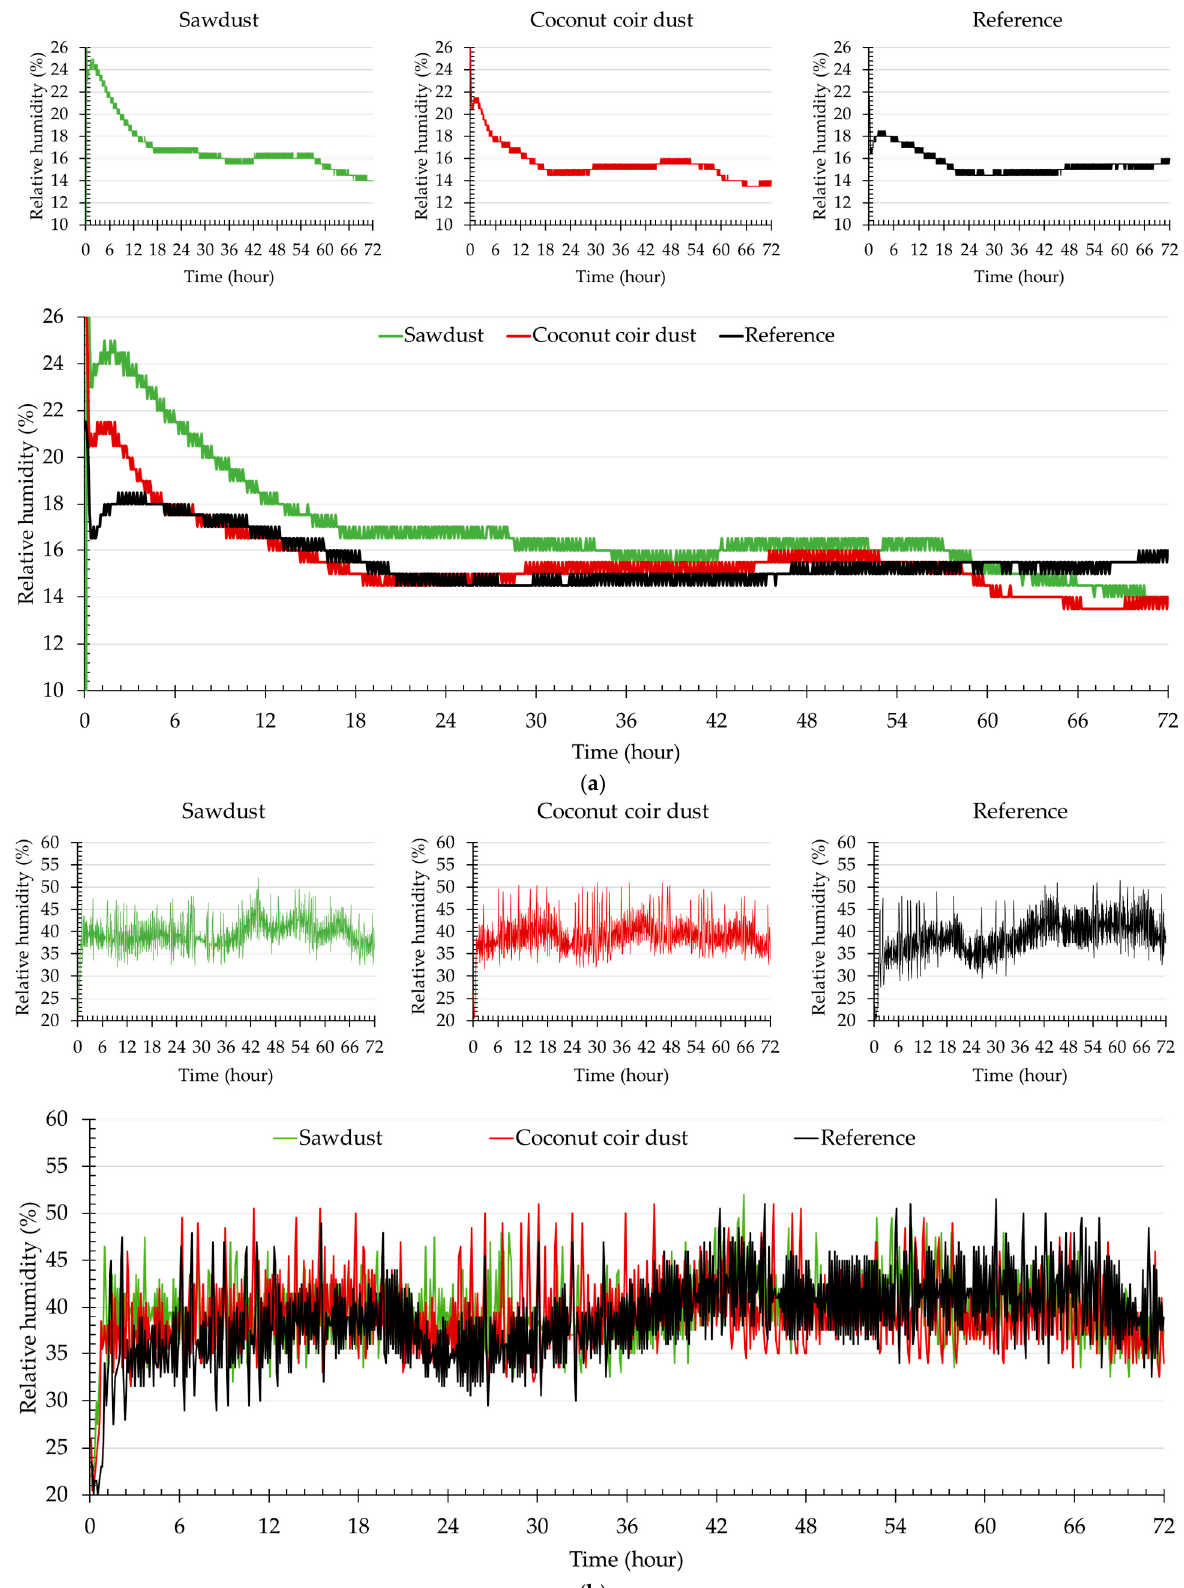
Figure 11. Relative humidity (72 h): ( a ) hot chamber; ( b ) cold chamber.